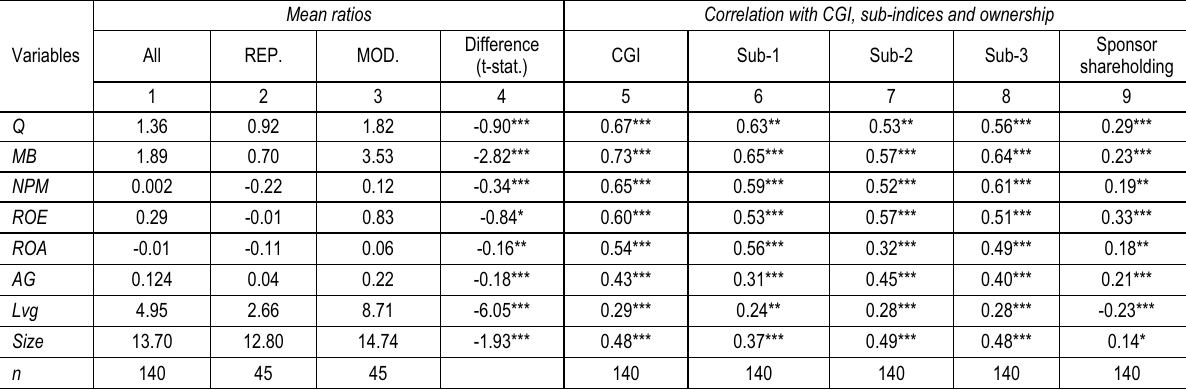
Table 3. Corporate governance and several firm characteristics